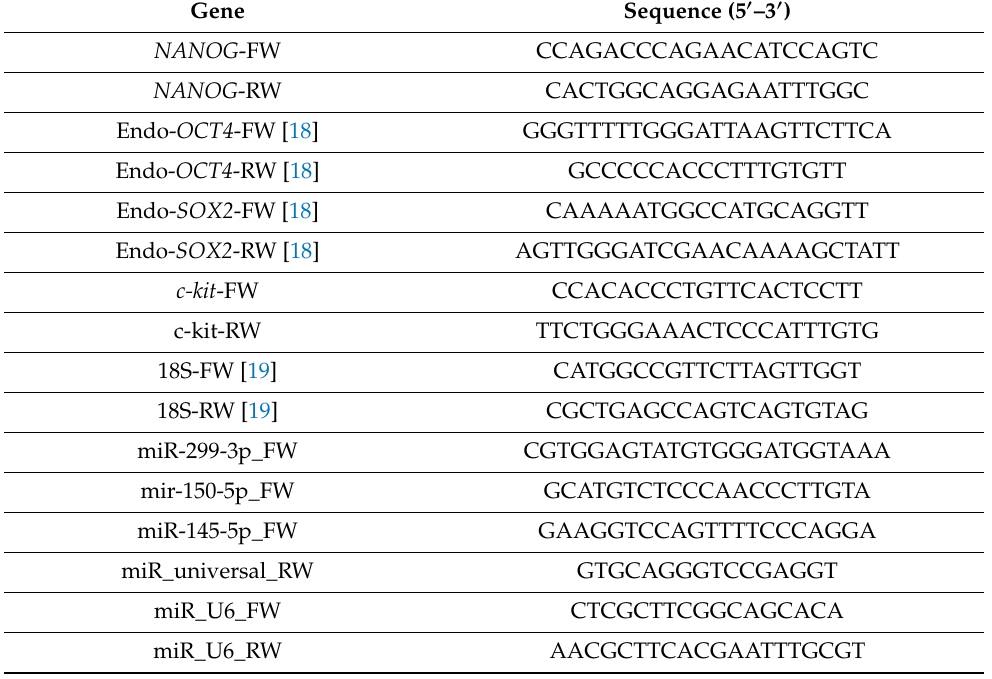
Table 3. The primers for real time